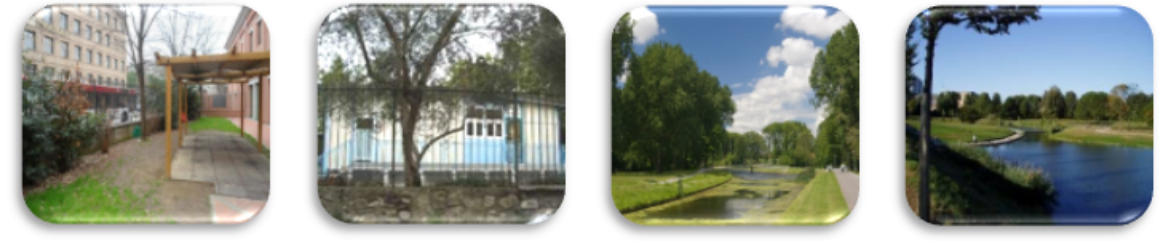
Figure 9: Example of interventions performed in Vamba and Dionisi schools (a green and glass barrier, respectively) and in Spinoza and Southern parks (low noise paving).